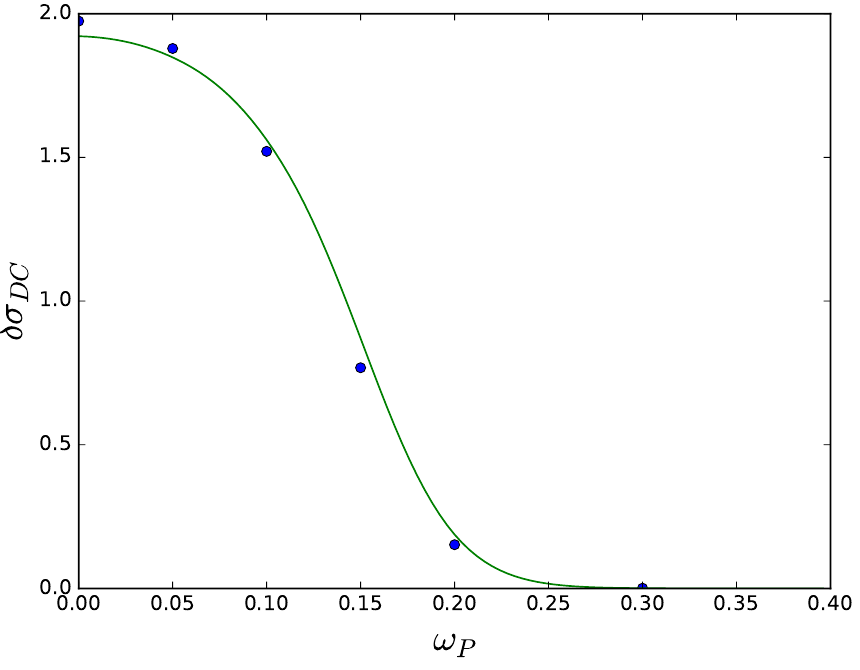
Figure 12 . The maximum deviation of the DC conductivity from its thermalized value as a function of the pump frequency ! P . The solid green curve is a one parameter (cid:12)t to a form ( E x ( ! (cid:3) ))